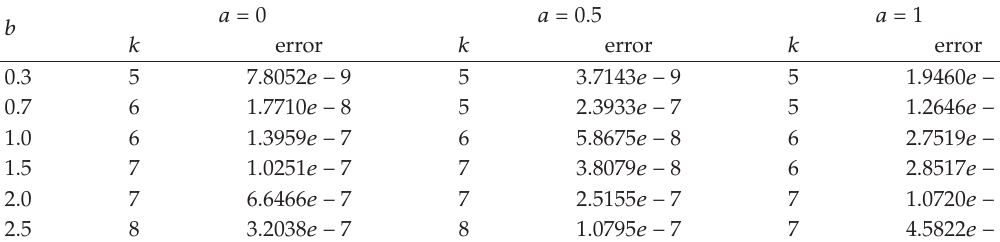
Table 7: Convergence of the method in Example 4.5 for grid 65 ×